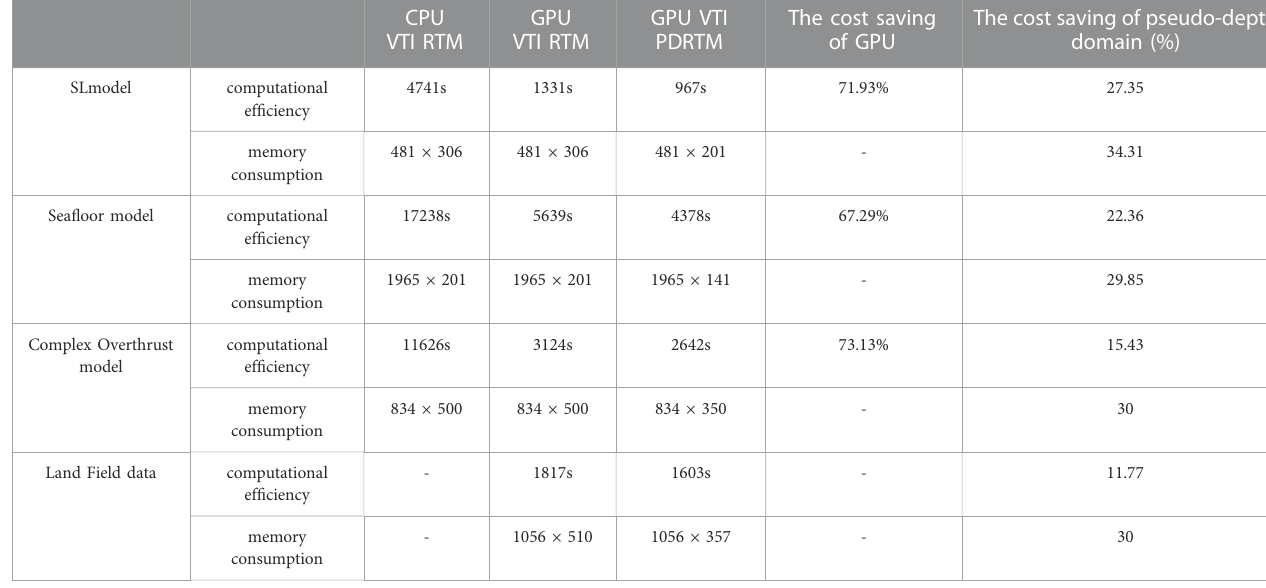
The cost saving of pseudo-depth domain